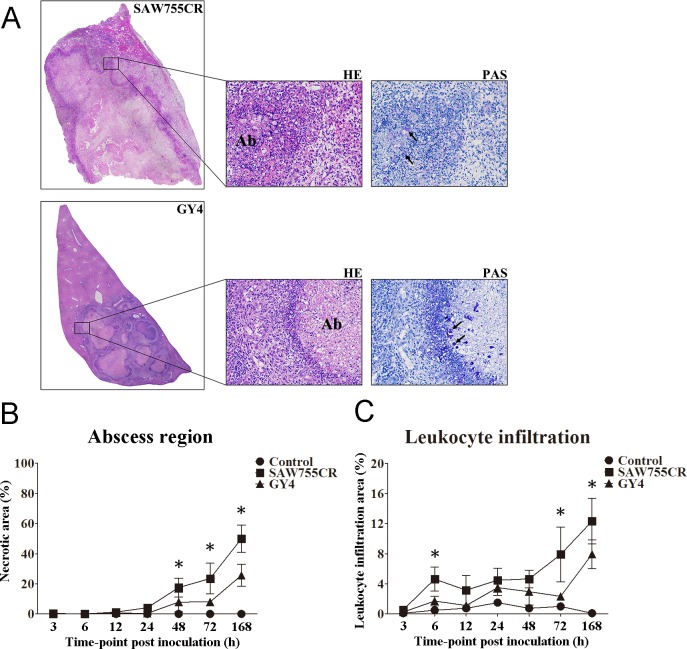
Histological features of liver in hamsters inoculated with trophozoites of E. histolytica or E. nuttalli.(A) Tissue section stained with hematoxylin and eosin (HE) and periodic acid-Schiff (PAS). Hamsters were inoculated with 1×106 trophozoites of E. histolytica SAW755CR strain or E. nuttalli GY4 strain. Seven days after inoculation, multiple PAS-positive trophozoites (arrows) and inflammatory cells were observed in peripheral areas of necrosis (Ab). (B,C) Quantification of abscess region (B) and leukocyte infiltration region (C) in liver sections. Regions were evaluated in each slide of livers from hamsters (6 to 7 in each group) at different times and analyzed using Image-Pro Plus 4.5.1. Areas of interest are expressed as the percentage of the total tissue area. * P <0.05 by two-tailed Student t-test.